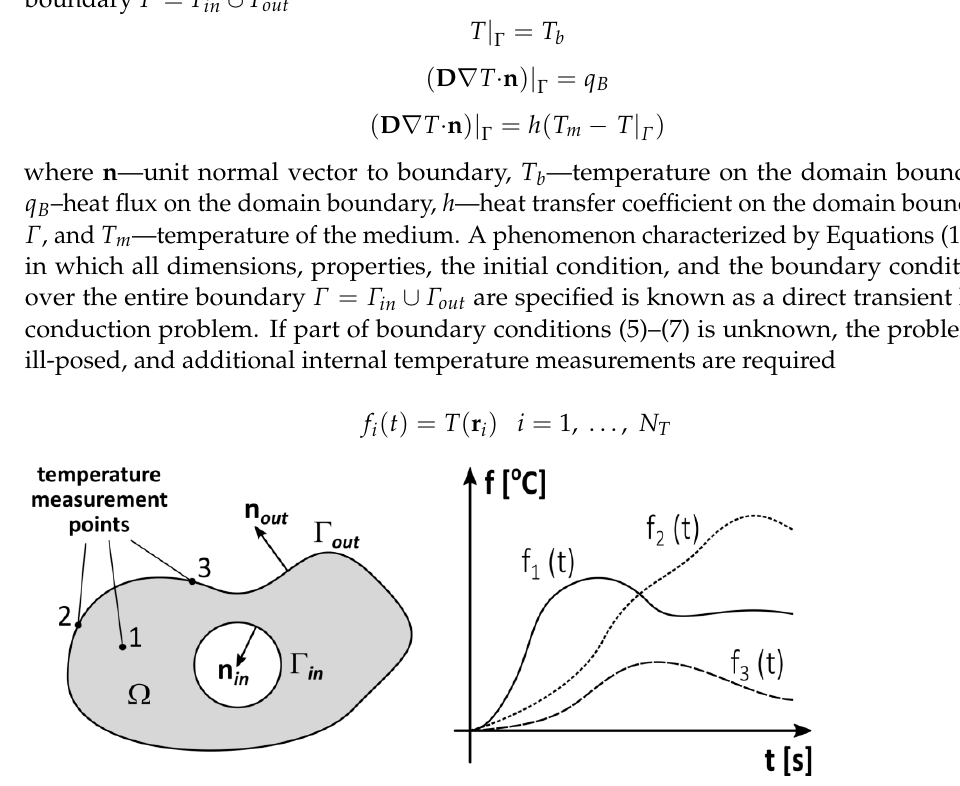
Figure 1. Non-simply connected domain Ω bounded by boundary Γ = Γ in ∪ Γ out .